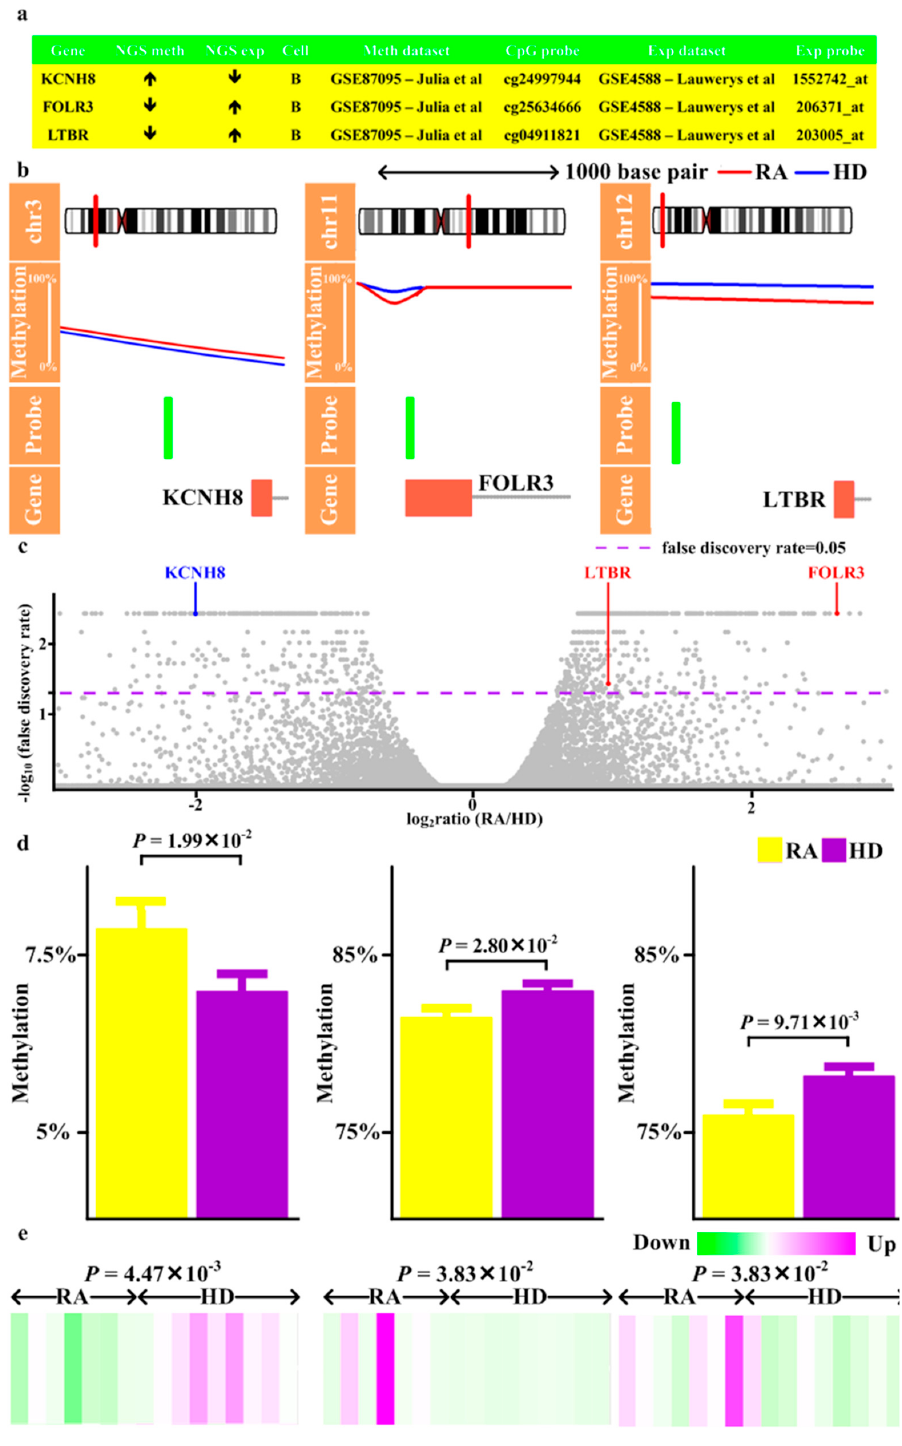
Figure 5. Validation of genes with differential methylation in promoter and differential expression . ( a ) The results of methylation and expression obtained from next-generation sequencing (NGS meth, NGS exp), the cell subsets of validation dataset (Cell), the dataset of validation (Meth dataset, Exp dataset), and the probes of validation dataset (CpG probe, Exp probe). ( b ) Visualization of the methylation levels obtained from NGS in RA and healthy donors (HD) and location of validated CpG probe superposed onto the genomic locations of genes. ( c ) Volcano plot of the -log 10 (false discovery rate) on the Y-axis versus expression change (log 2 ratio) on the X-axis. Of validated genes, ( d ) Methylation and ( e ) Expression levels of corresponding probes in the validation dataset.